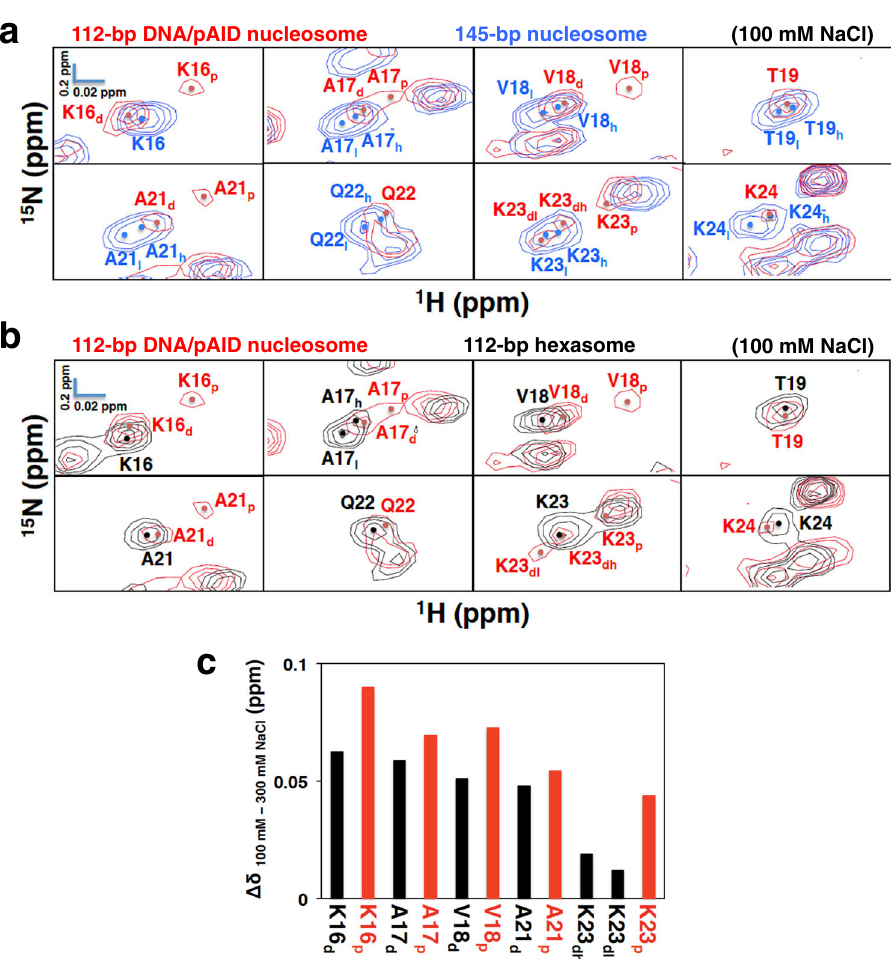
Fig. 5 Conformational comparison of the H2B BS2 region under the physiological salt condition. a , b Expanded signal comparison between the 112-bp DNA/pAID nucleosome (red) and the 145-bp nucleosome (blue) ( a ) or the 112-bp hexasome (black) ( b ) at 100 mM NaCl. NMR signals are divided into panels by amino acid residue (Lys16 – Thr19 and Ala21 – Lsy24 of H2B). Signal assignments in the 112-bp DNA/pAID nucleosome, 145-bp nucleosome, and 112-bp hexasome are labeled in red, blue, and black, respectively. Filled circles indicate each signal center. pAID and DNA side signals are designated by subscript p and d, respectively. High- and low- fi eld components of the signals are designated by subscript h and l, respectively. c Histogram showing chemical shift differences between 100 mM and 300 mM NaCl of the pAID and DNA side signals in the H2B BS2 region of the 112-bp DNA/ pAID nucleosome. Chemical shift differences are plotted for pAID side (red) and DNA side (black) residues in the H2B BS2